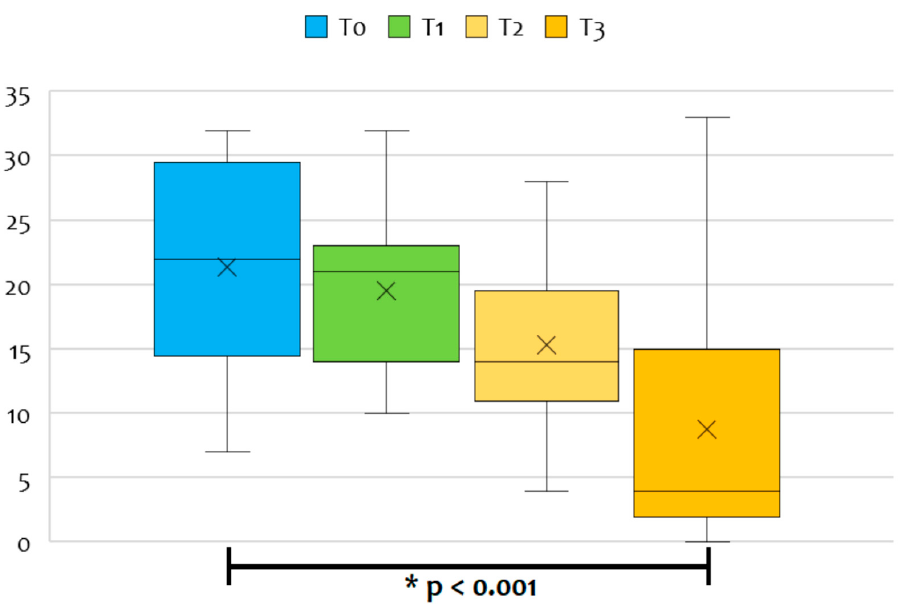
Figure 2. The median CDH-LUS score during the first 24 h of life (T0), at 24–48 h of life (T1), within 12 h of surgical repair (T2), and a week after the surgical repair (T3).